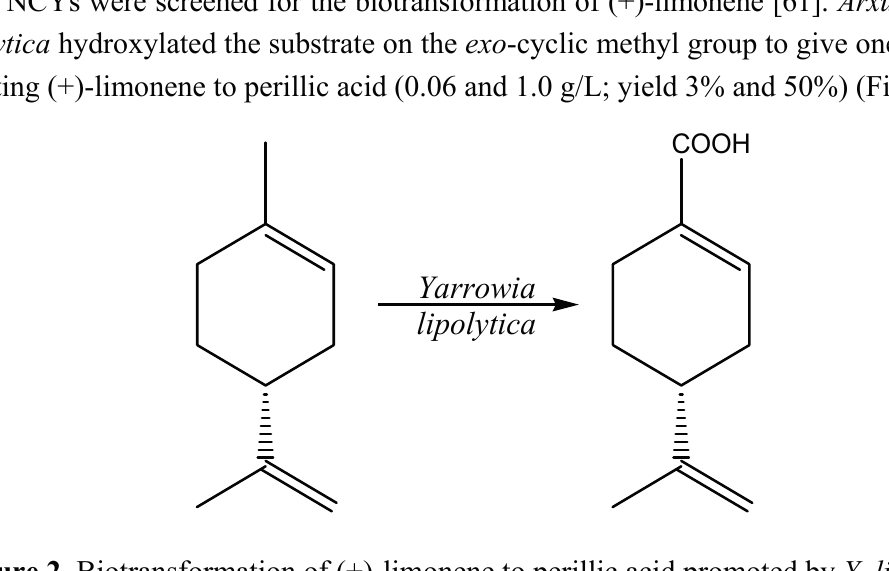
Figure 2. Biotransformation of (+)-limonene to perillic acid promoted by Y. lipolytica